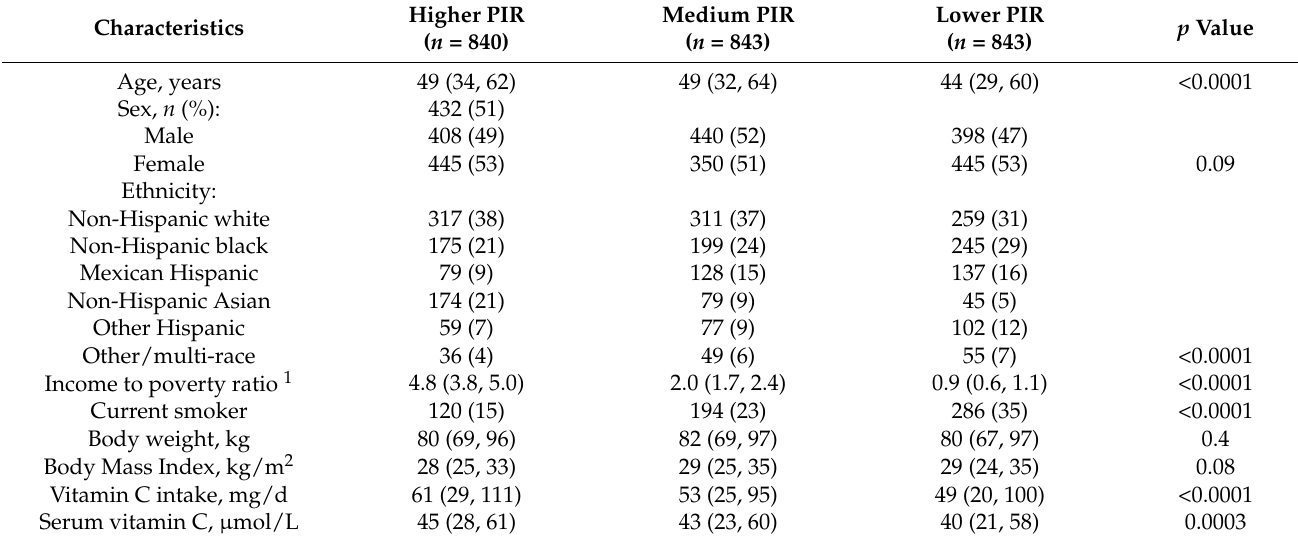
Table 7. Cohort characteristics stratified by socioeconomic status.